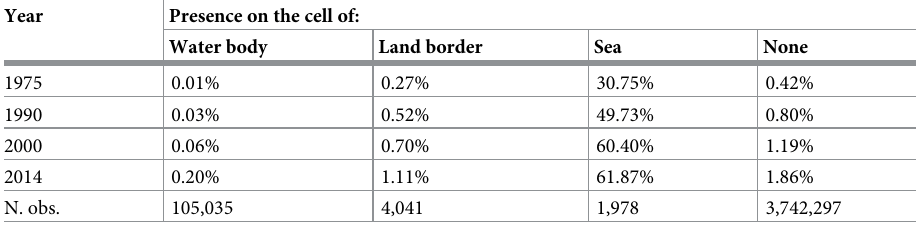
Table 6. Breakdown of built-up proportion by boundary